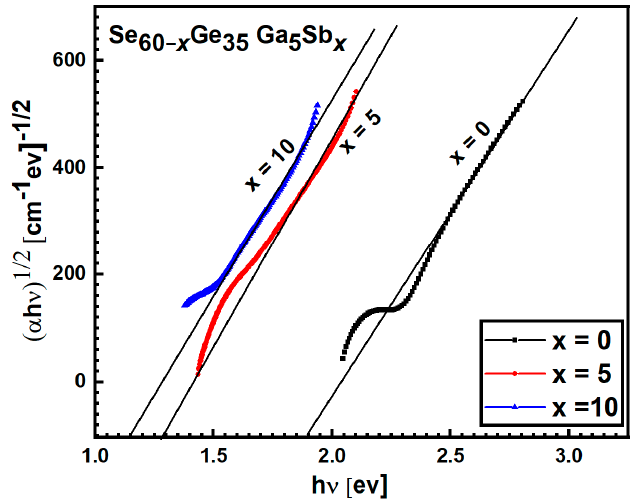
Figure 8. The relation of ( α h ν ) 1/2 with respect to h ν for Se 60 − x Ge 35 Ga 5 Sb x ( x = 0, 5, 10) films. It is observed from Table 3 that with increasing Sb content, the estimated optical energy gap E g in direct and indirect transitions decreases while the Urbach energy E e rises. This agrees with the effect of Sb on chalcogenide films in References [31,32], which might be due to the higher compositional disorder of chalcogenide glasses [26]. The presence of Sb induces localized states in the band gap, which causes the band edges’ tailing [31]. Increased band tailing in the gap can explain the reduction in E g in amorphous films